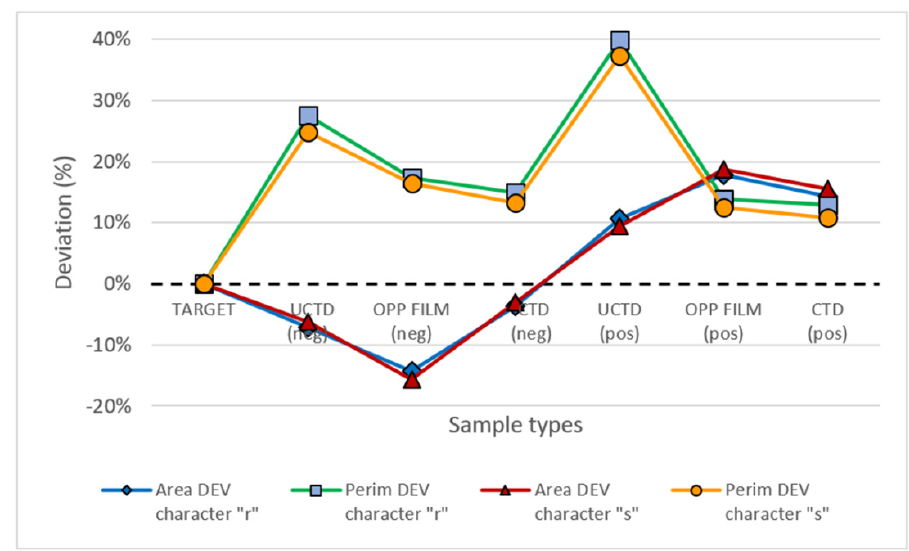
Figure 6. Deviation of area and perimeter (%) for text characters “r” and “s” of 8 pt size printed in positive and negative shape on three different printing substrates.